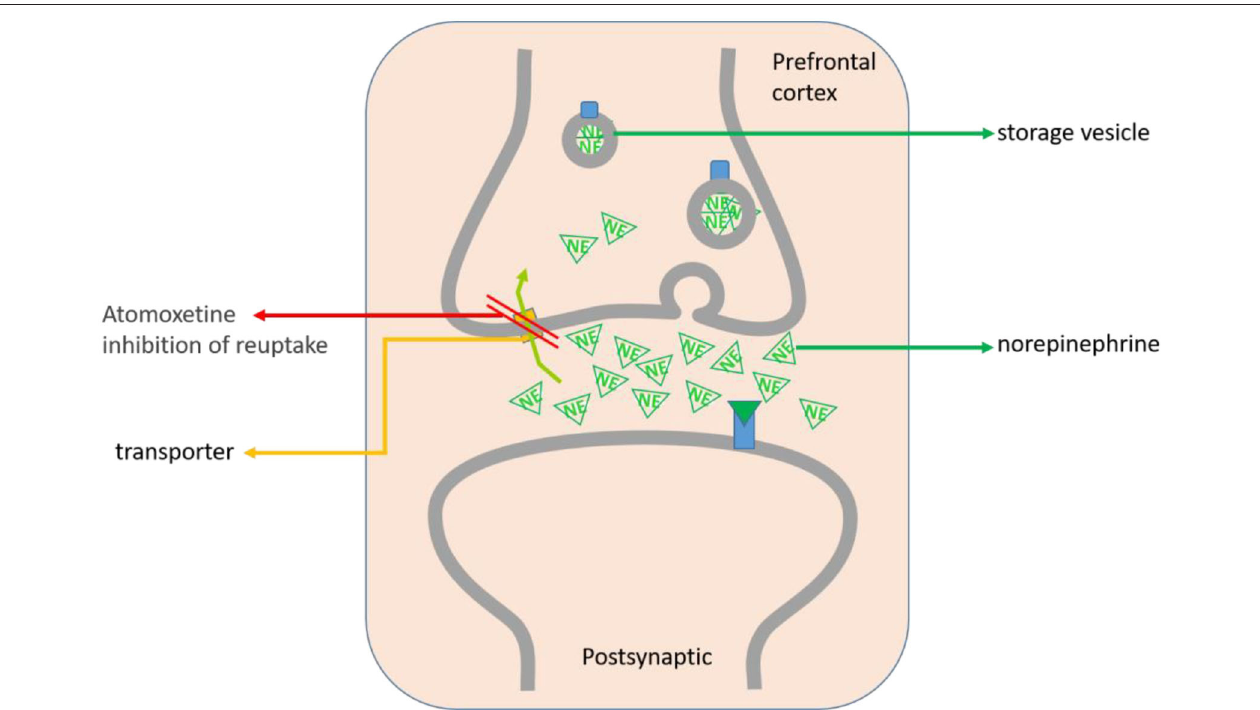
FIGURE 1 | The MOA of atomoxetine on ADHD treatment is mainly located in the PFC. Atomoxetine can highly bind to the NE reuptake transporter on the presynaptic membrane of the PFC, selectively inhibit NE reuptake and increase the NE in the synaptic cleft of neurons. Atomoxetine can also modulatethe dopamine uptake in the synaptic cortex through NET, and increase the dopamine level in the PFC, but not in the nucleus accumbens and striatum.